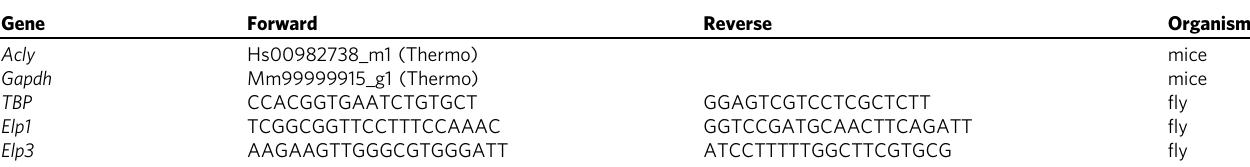
Table 3 List of PCR